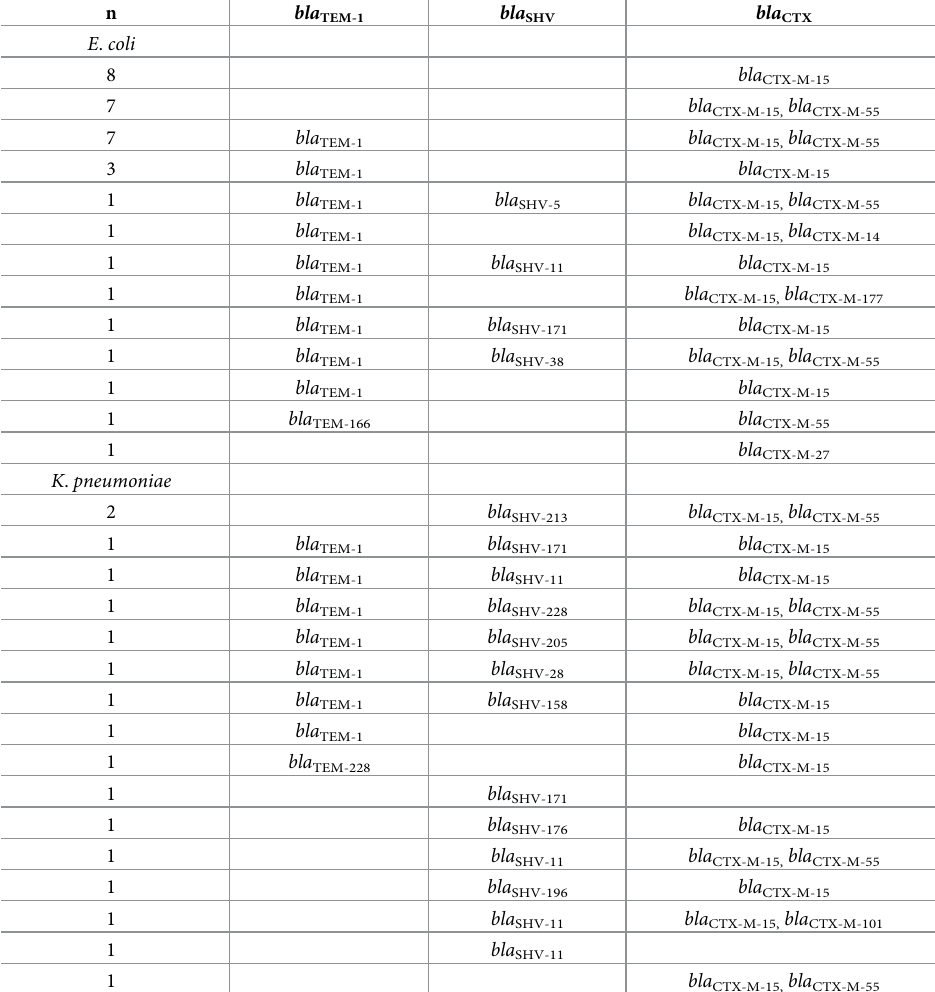
Table 5. Distribution of ESBL genotypes among E . coli and K . pneumoniae selected isolates. n bla